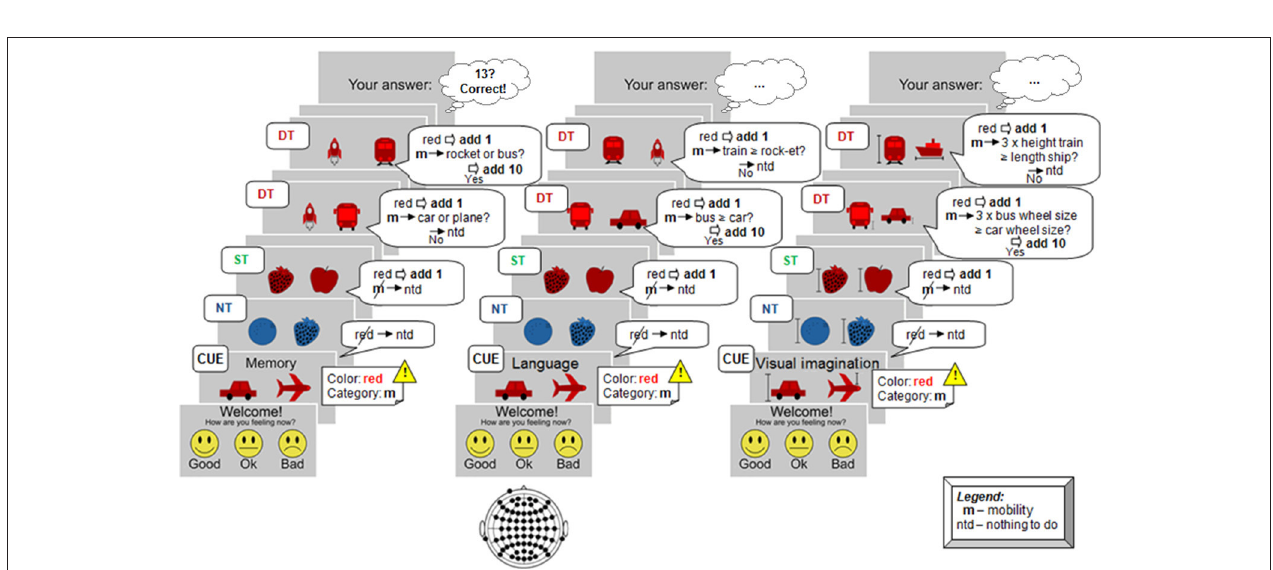
FIGURE 2 | Example of experimental protocol. At each stimulus participants had to perform or not a specific task, involving mental computation as a result. The total number counted was inserted at the end of the run. From left to right, the cognitive processes are illustrated here: memory case (recall memory and compare with the last target pair), language (compare the number of syllables), and visual imagination (imagine the objects in reality and perform dimensions